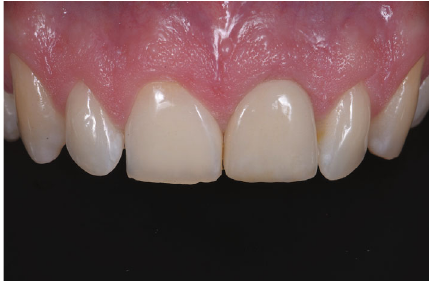
Figure 15: Final upper left central incisor restoration after 1 year in function.